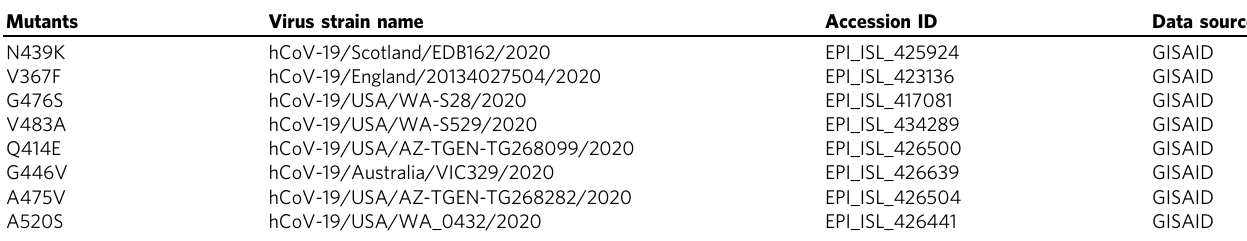
Table. 1 Information of SARS-CoV-2 RBD